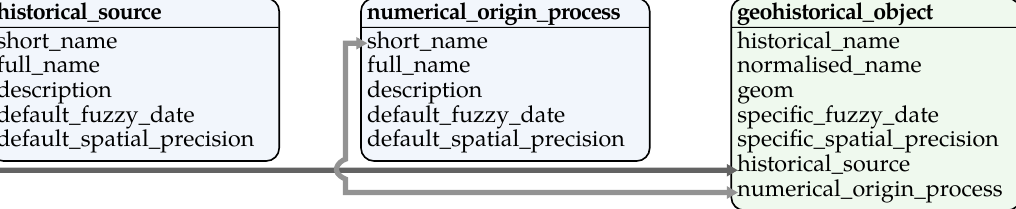
Figure 3. The geohistorical object model, where each object is characterized by its historical source (e.g., the historical map in which the object was described) and a numerical origin process, which is the process through which the object was digitized. Aside from source and origin processes, an object is also described by a fuzzy date, a text, and a geometry.